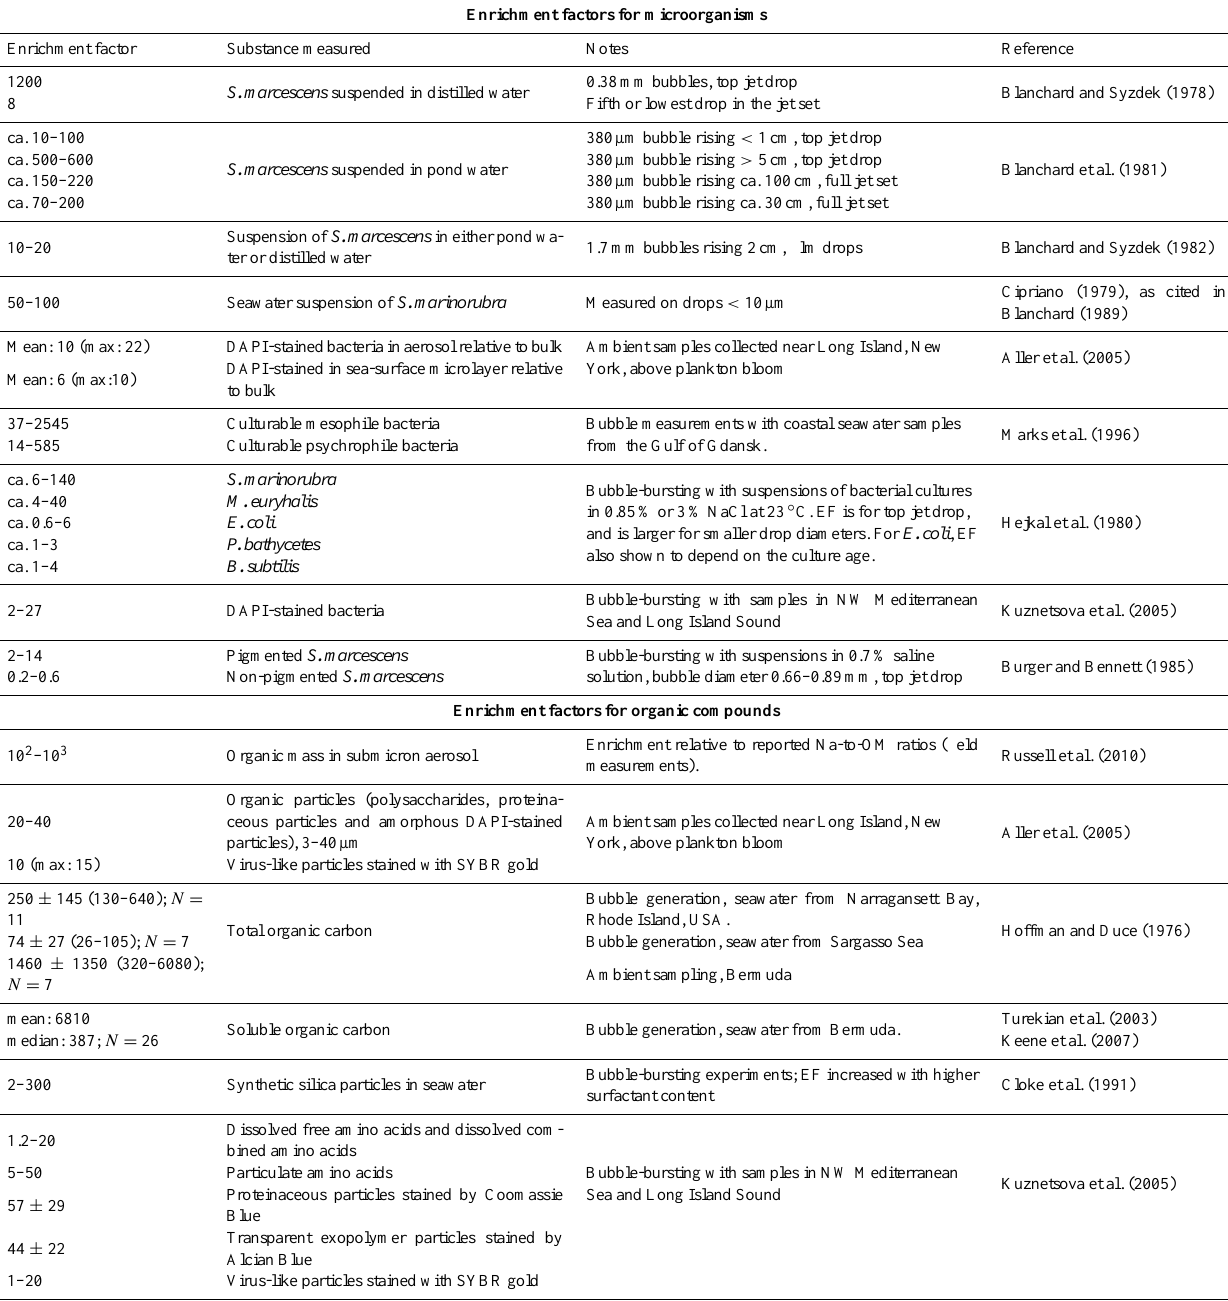
Table B1. Enrichment factors reported from field measurements and laboratory experiments for aerosolized marine bacteria and organic